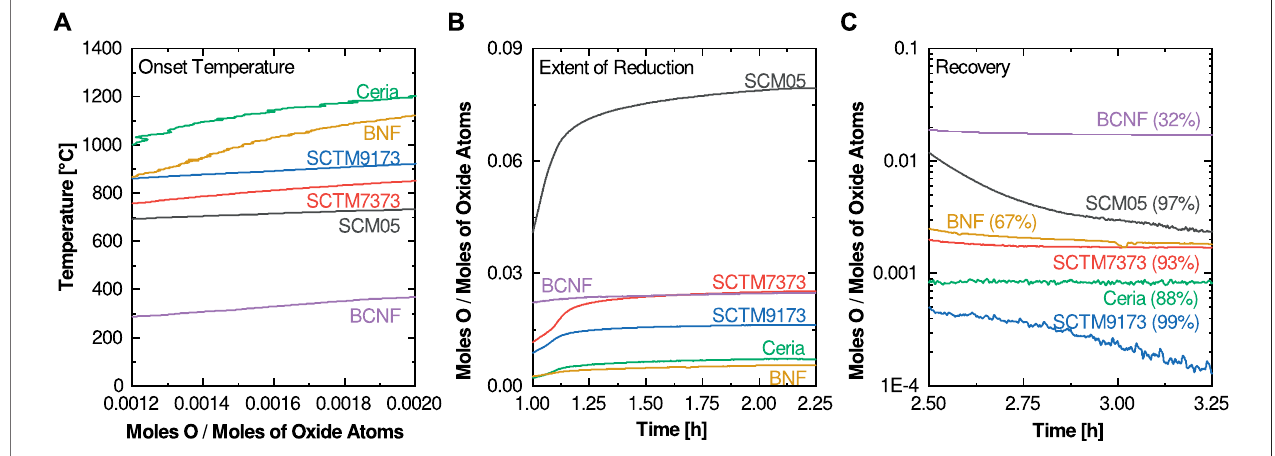
FIGURE 5 | Highlight plots of the relevant experimental data regions for the three fi gures of merit after re-normalization using moles of oxide atoms: (A) Onset temperature, (B) Extent of reduction, and (C) Recovery (calculated percentage of reoxidation at 1,000 ° C is also